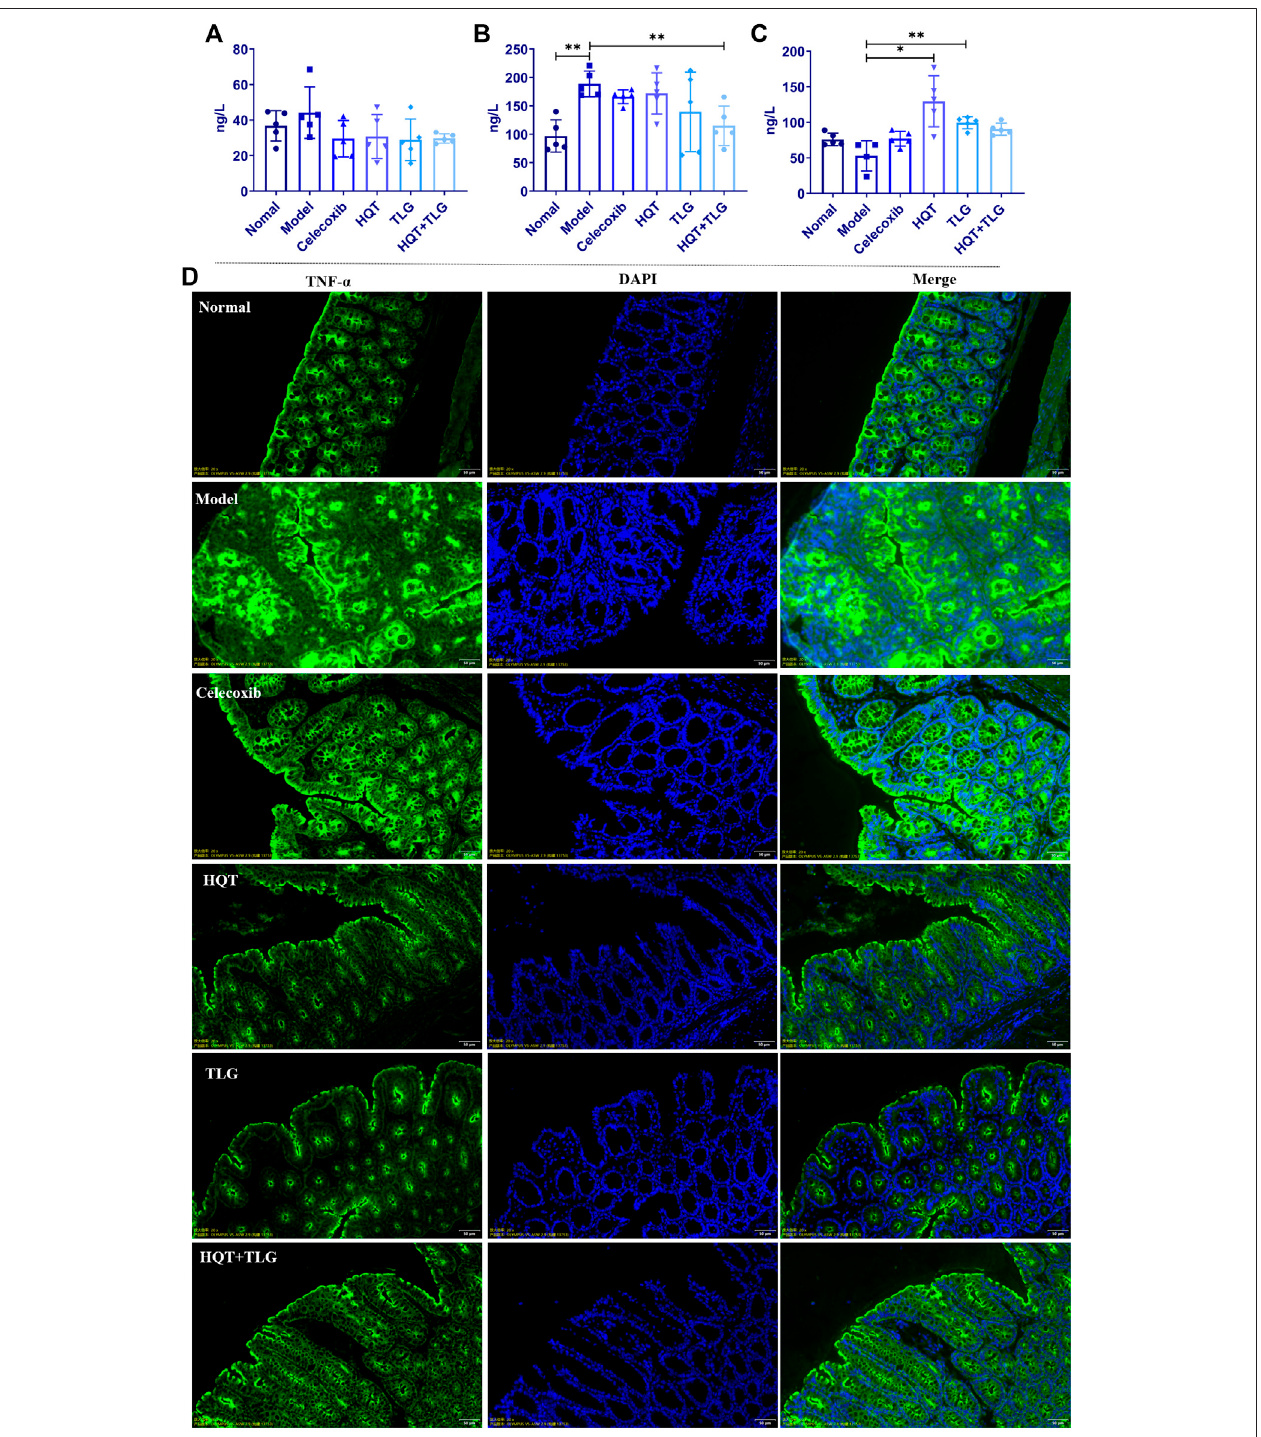
FIGURE 3 | The levels of in fl ammatory factors and the expression of TNF- α in colon tissue of mice in each group. The levels of (A) IL-6, (B) TNF- α , and (C) IL-10 in the colorectum of the mice. (D) The expression of TNF- α in colon tissue of mice. Compared with the model control group, * p < 0.05, ** p < 0.01.